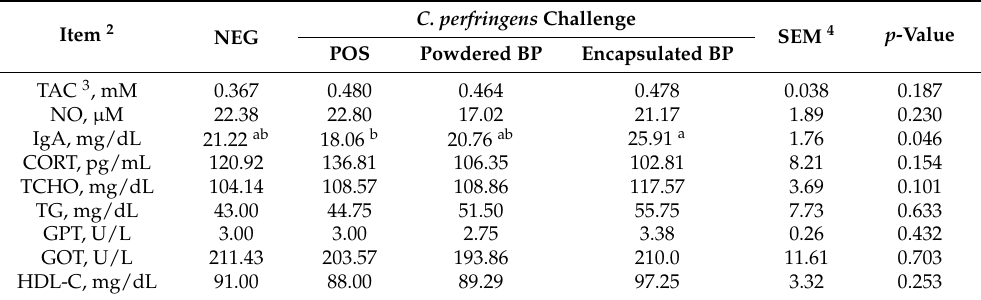
Table 6. Effects of dietary encapsulated and powder BPs on serum parameters in broiler chicken challenged with C. perfringens 1